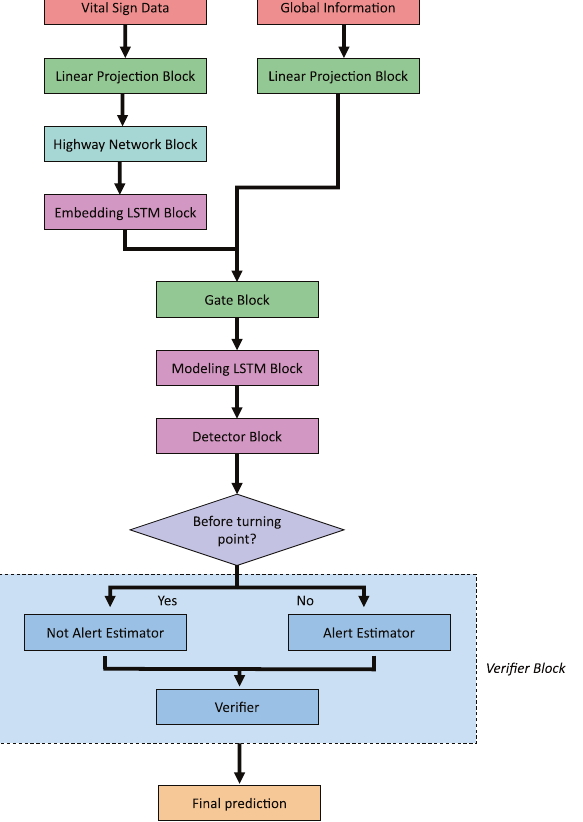
Fig. 1 Architecture overview of DeepPBSMonitor . The vital sign and global data were integrated via linear projection, highway network, LSTM, gate,detector and veri fi er blocks.